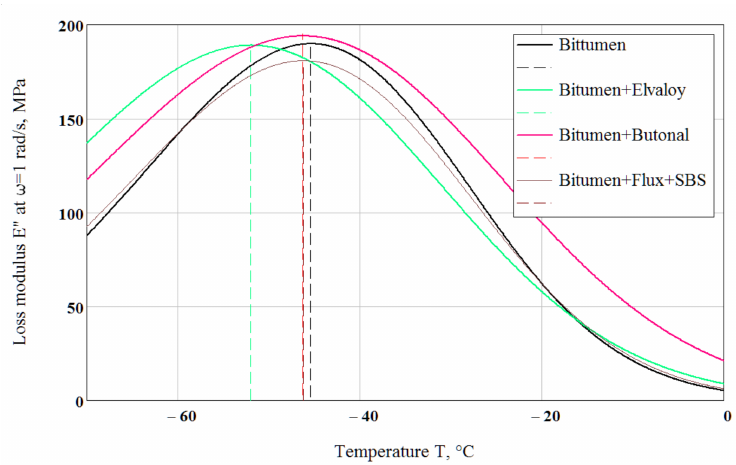
Figure 8. Calculation of the glass transition temperatures for the tested binders using the loss modulus peak method at frequency ω = 1